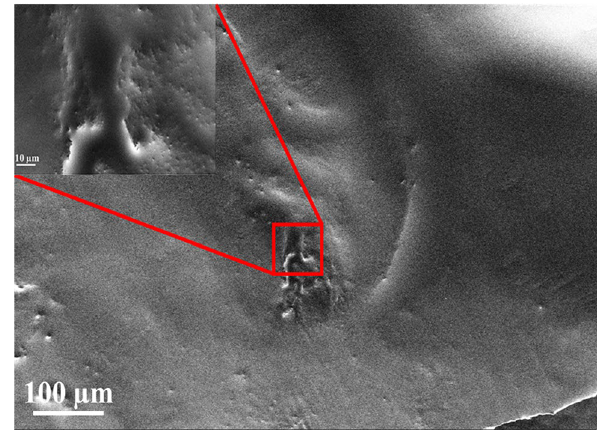
Figure 1. The SEM image of the absorber